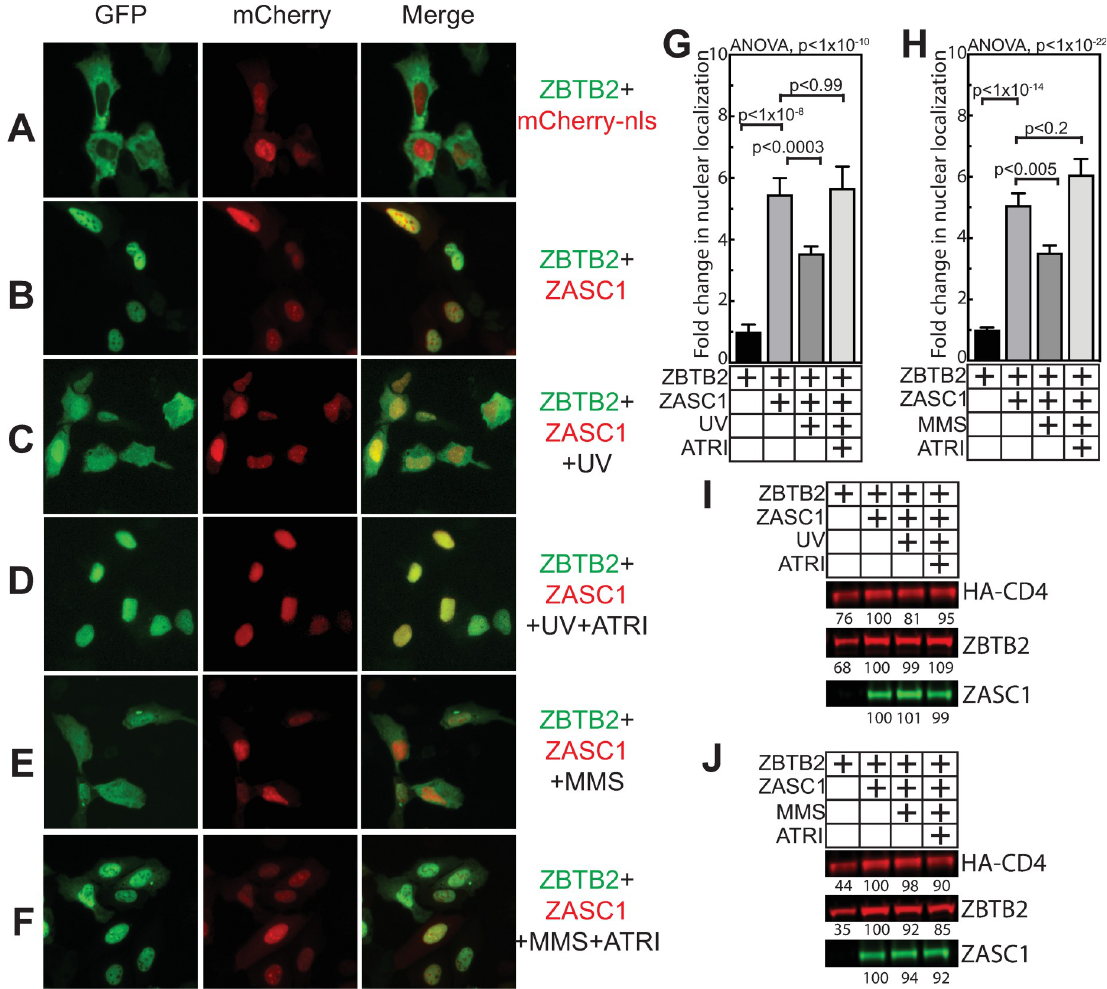
Fig 10. ZASC1 and the ATR kinase pathway regulate ZBTB2 localization. U2OS cells were transfected with GFP-ZBTB2 and either mCherry with a nuclear localization signal (A) or mCherry-ZASC1 (B-F) and imaged 24 hours post transfection. ATR kinase was activated by 320 nm UV light (C & D), 8 mM of the DNA damaging agent methyl methanesulfonate (MMS) ATR activation was inhibited by treating with 10 μ M of ATR inhibitor (CAS 905973-89-9) (D, F). (G and H) To quantify the effects observed in (A-F), independent transfections were performed with the indicated conditions and the relative ZBTB2 fluorescence signals in the nucleus and a nucleus- adjacent cytoplasmic ring were measured in � 100 cells, and the fold change in nuclear to cytoplasmic signal reported. (G) presents the effects of DNA damaging UV treatment and ATR inhibitor, and (H) presents the effects of 8 mM of the DNA damaging agent MMS and 10 μ M ATR inhibitor. Error bars indicate the standard deviation of the data in all panels. ANOVA analysis was performed and for P- values < 0.05 a Tukey’s HSD was performed and relevant P-values reported. Western blots showing the effects of (I) UV or (J) MMS treatment on the levels of ZASC1, ZBTB2 and a HA-tagged CD4 control protein. Numbers indicate band intensity relative to lane expressing both ZASC1 and ZBTB2. Results are representative of three independent